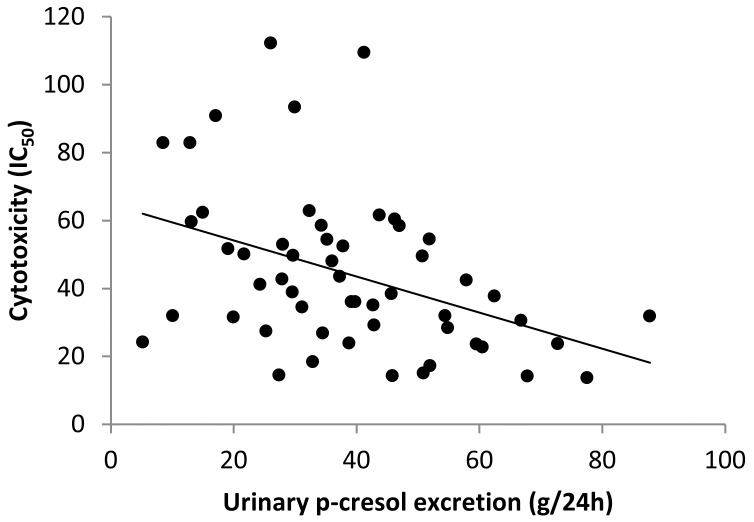
Scatter plot in which cytotoxicity (IC50) is plotted against urinary p-cresol excretion (mg/24 h).The plot shows a negative correlation between both parameters (Spearman’s r = −0.435, p = 0.001).